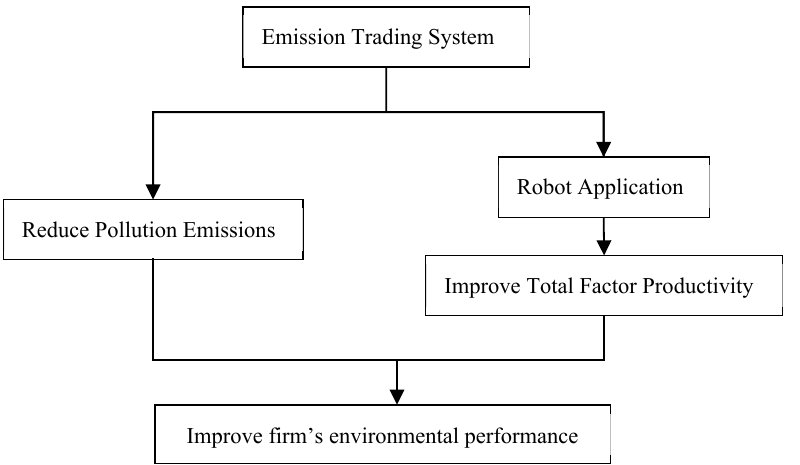
Figure 1. Mechanism diagram of the impact of the emissions trading mechanism on corporate environmental performance.